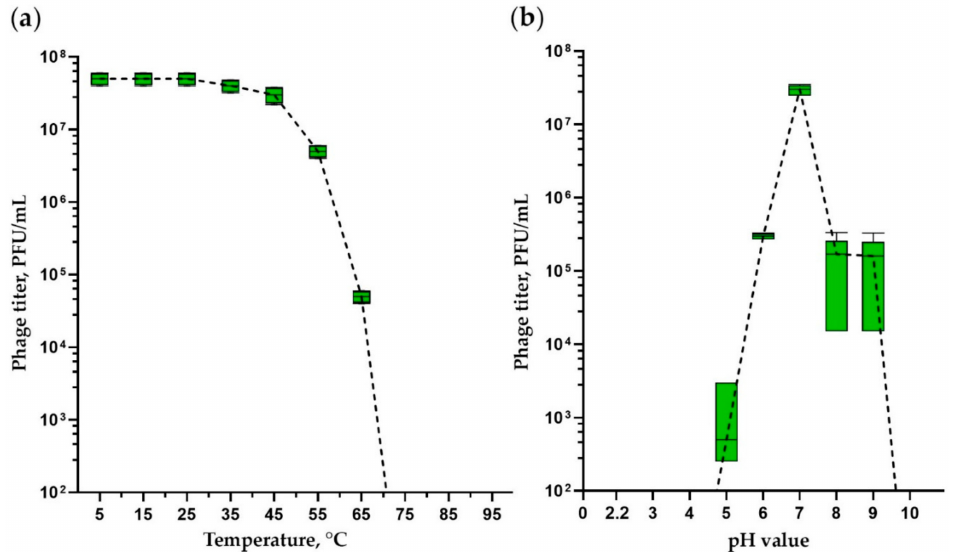
Figure 2. Thermal and pH stability of Enterococcus phage iF6. ( a ) Phage titers after 1 h incubation at temperatures ranging from 5 to 95 ◦ C. ( b ) Phage titers after 1 h incubation at pH values ranging from 2.2 to 10. The graphs were created in GraphPad Prism 8.4.3 with a 95% confidence interval. Five independent trials were performed for the